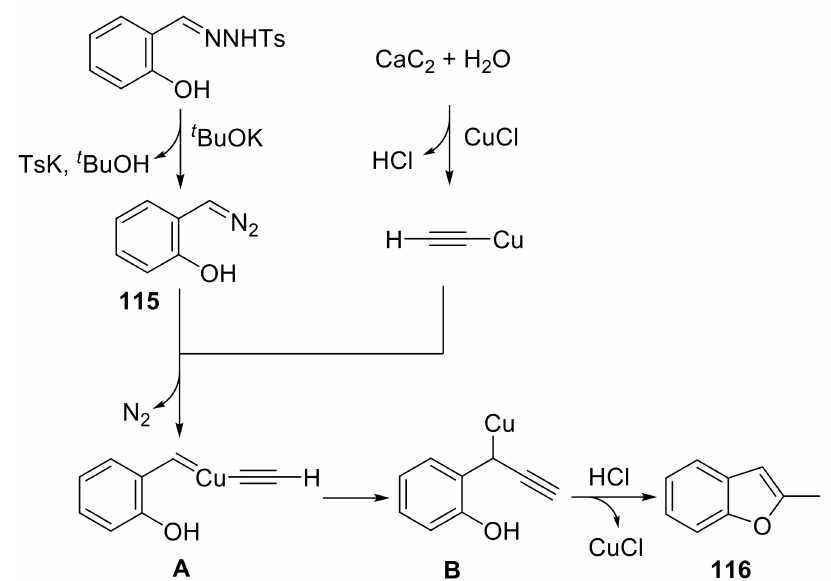
Scheme 64. Mechanism of benzofuran formation.